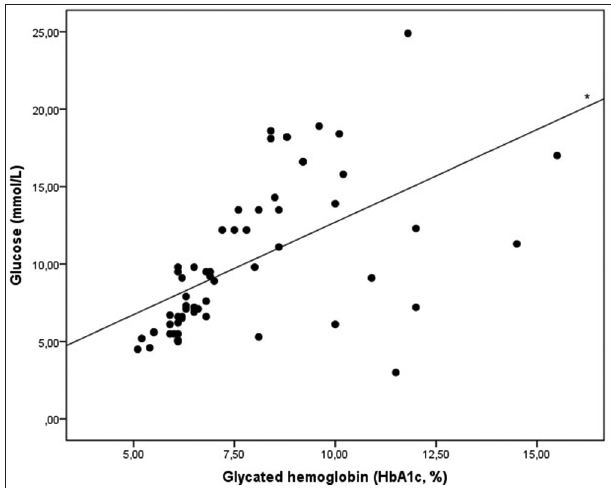
FIGURE 1. Correlation between concentrations of serum glucose and glycated hemoglobin (* r =0.560, p